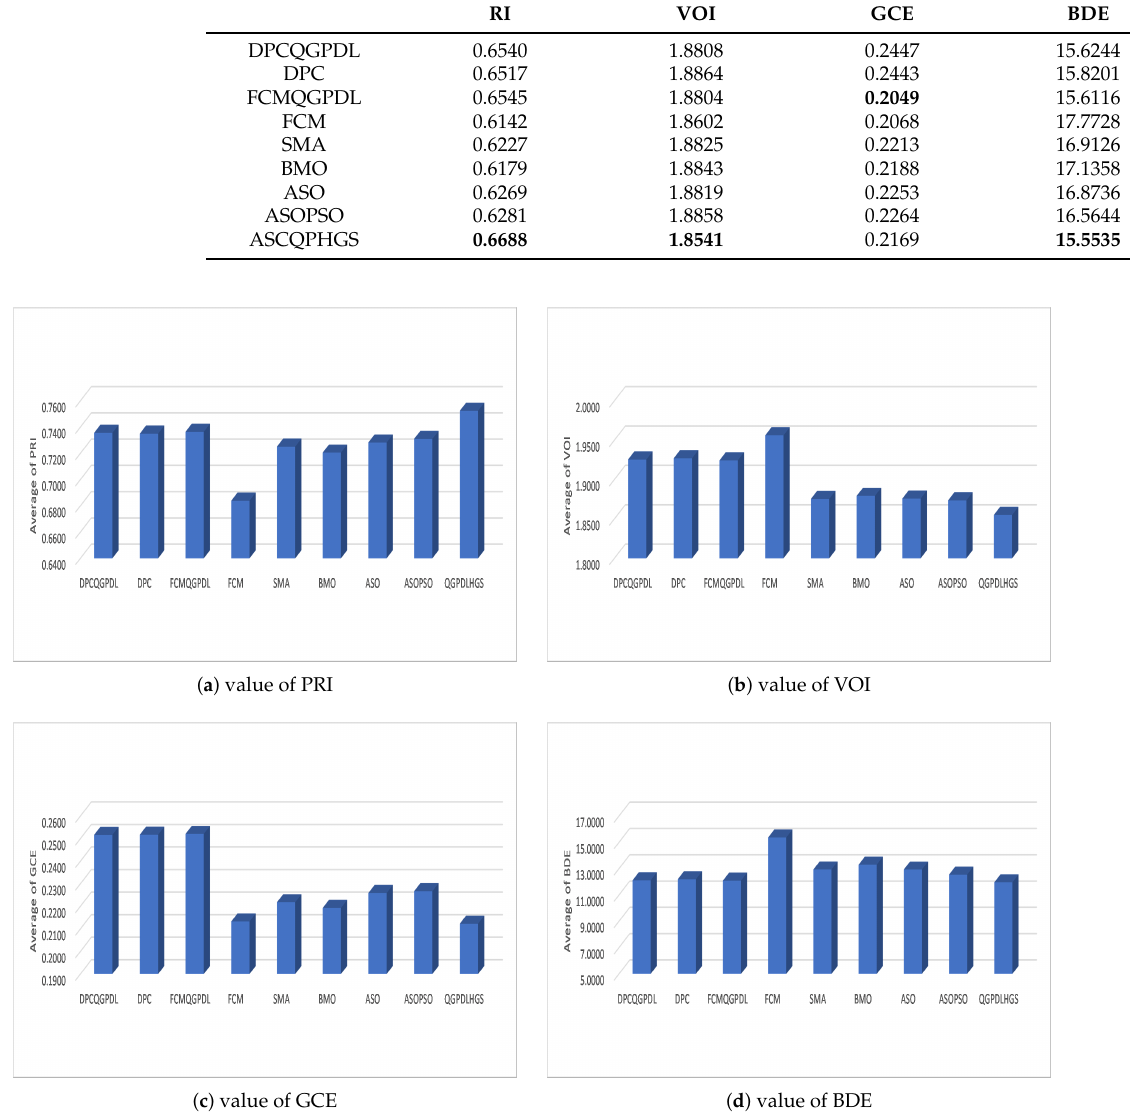
Figure 4. Comparison results between ASCQPHGS and other models in terms of PRI, VOI, GCE, and